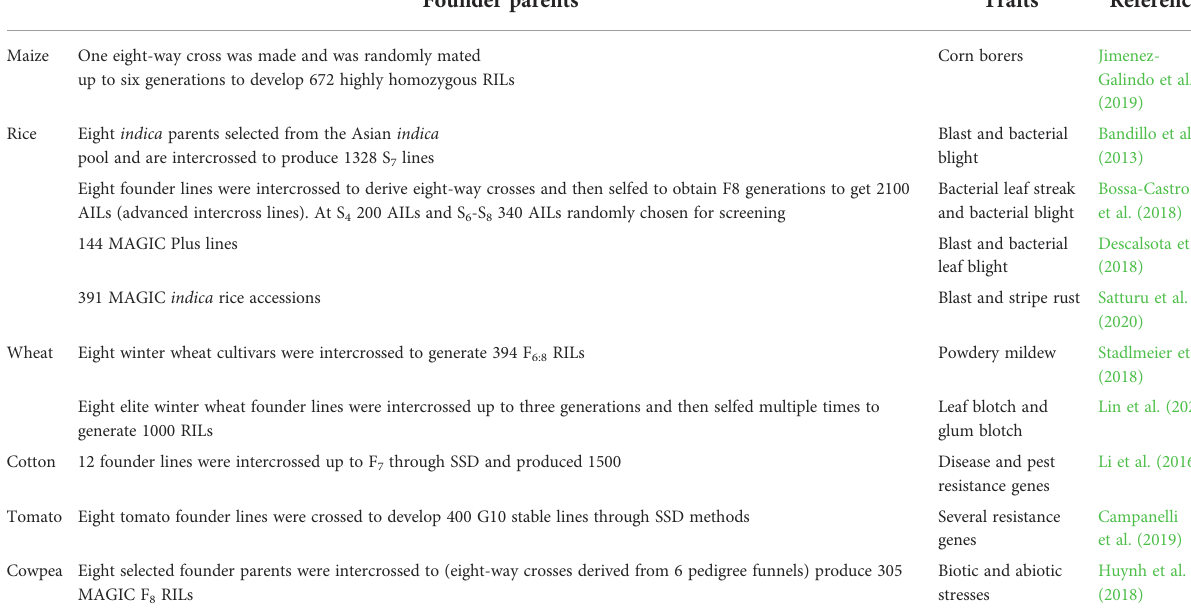
TABLE 2 Summary of multi-parent populations used for identifying MTAs for disease resistance in different